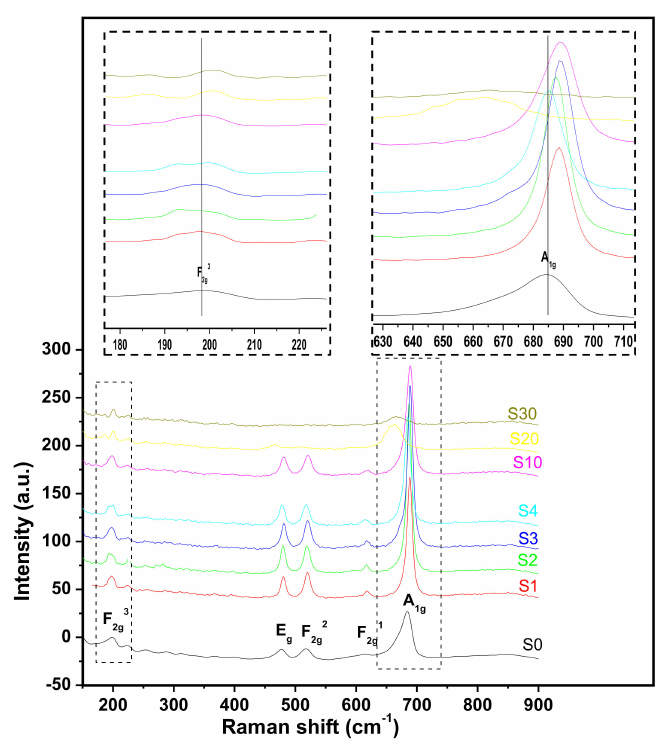
Figure 7. Raman spectra of samples S0, S1, S2, S3, S4, S10, S20 and S30 obtained by the first synthesis route. Inset is zoom of F 2g3 and A 1g peaks located respectively at 200 cm − 1 and 685.7 cm − 1